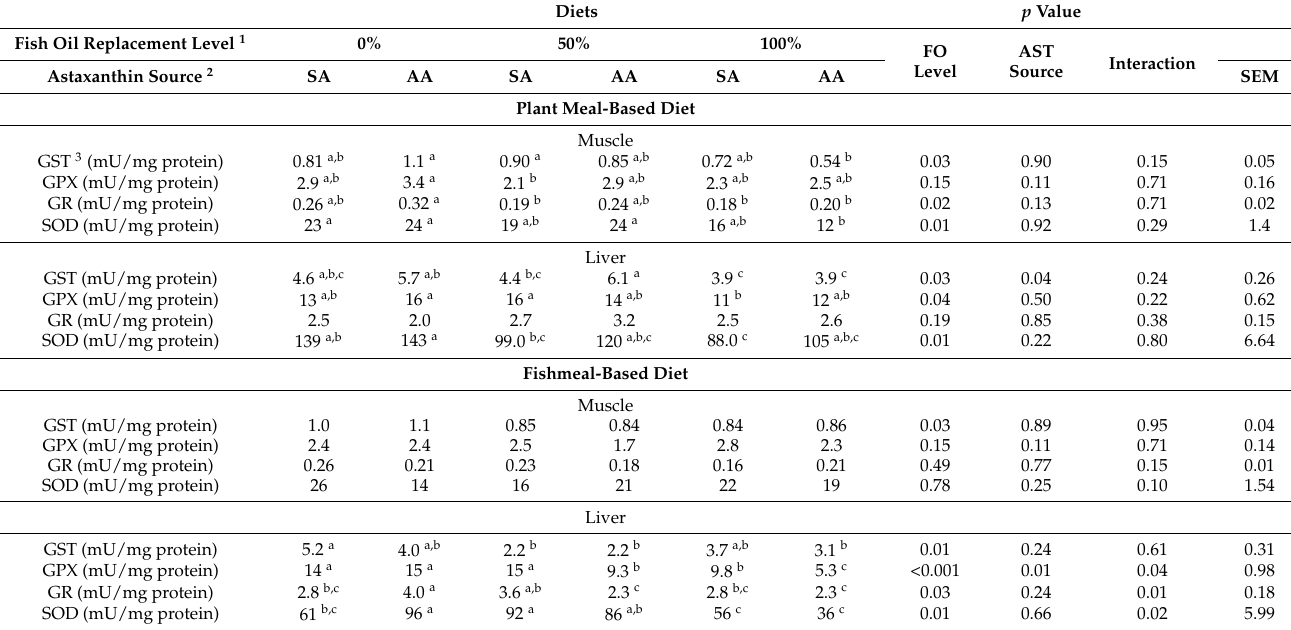
Table 2. Effects of dietary fish oil substitution by DHA-rich microalgae and source of astaxanthin on antioxidant enzyme activities in the muscle (fillet) and liver of juvenile rainbow